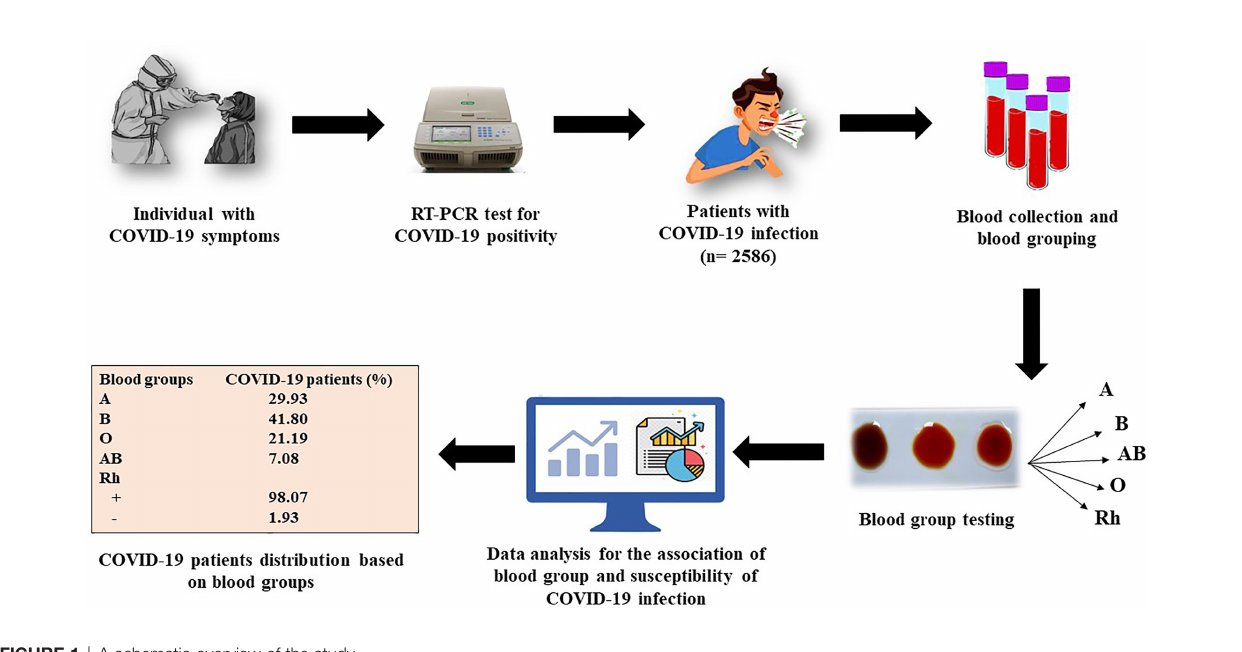
FIGURE 1 | A schematic overview of the